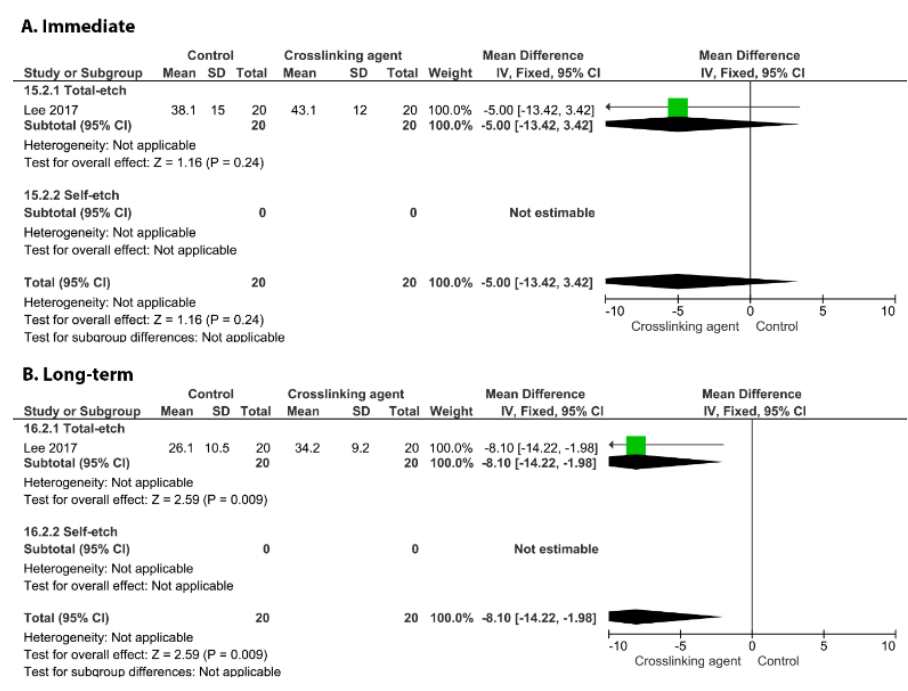
Figure 10. Forest plot of the immediate ( A ) and long-term ( B ) bond strength comparison between the glutaraldehyde crosslinking agent and the control according to the adhesive used, [99].